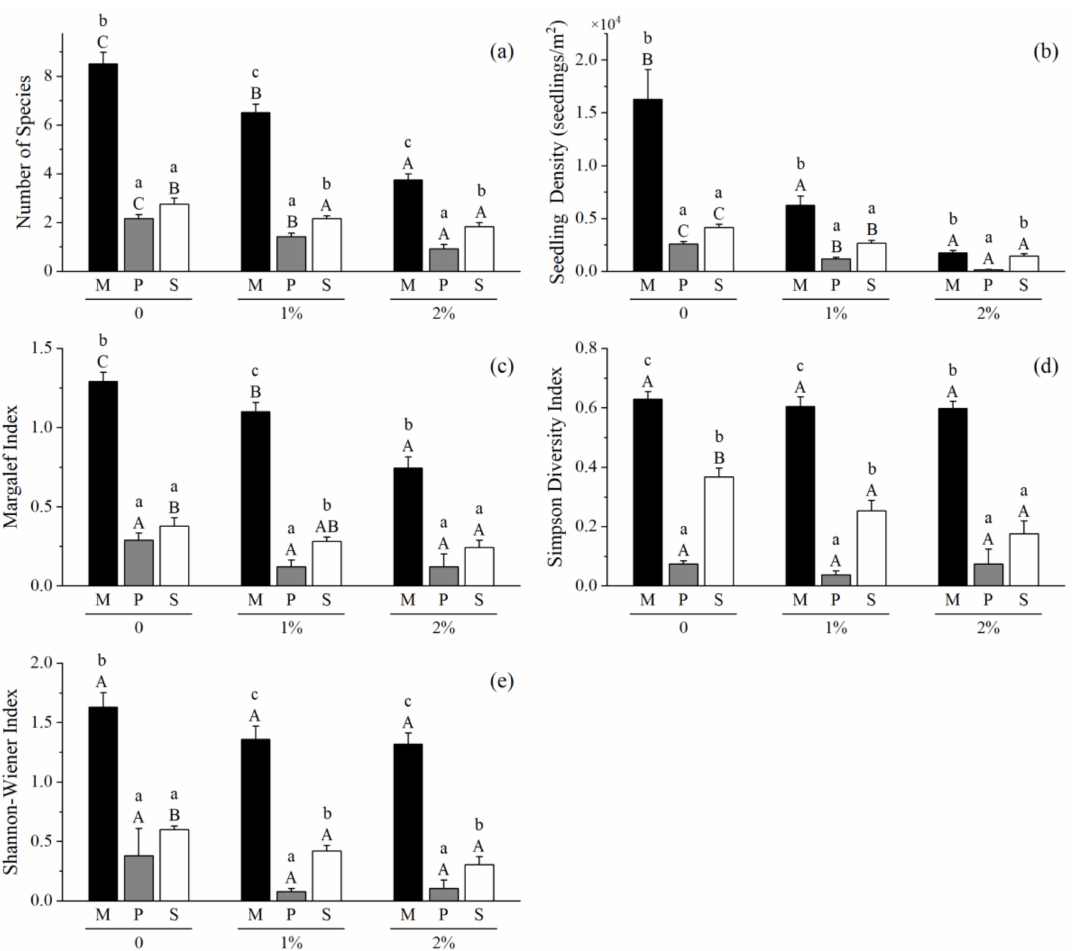
Figure 1. Effects of salinity on the seed germination of the three dominant communities in the YRD. ( a – e ) are the different parameters to describe the seed germination characteristics under different salinity. The columns are the mean values of the parameters, and the error bars are the standard error of the values, N = 4, p = 0.05. M: Multi-species community; P: Phragmites australis community; S: Phragmites australis – Suaeda glauca community. The 0%, 1% and 2% refers to the different soil salinities; a, b and c are used to describe the significance of the differences among the three communities under the same soil salinity; A, B and C are used to describe the differences among the three soil salinities under the same community